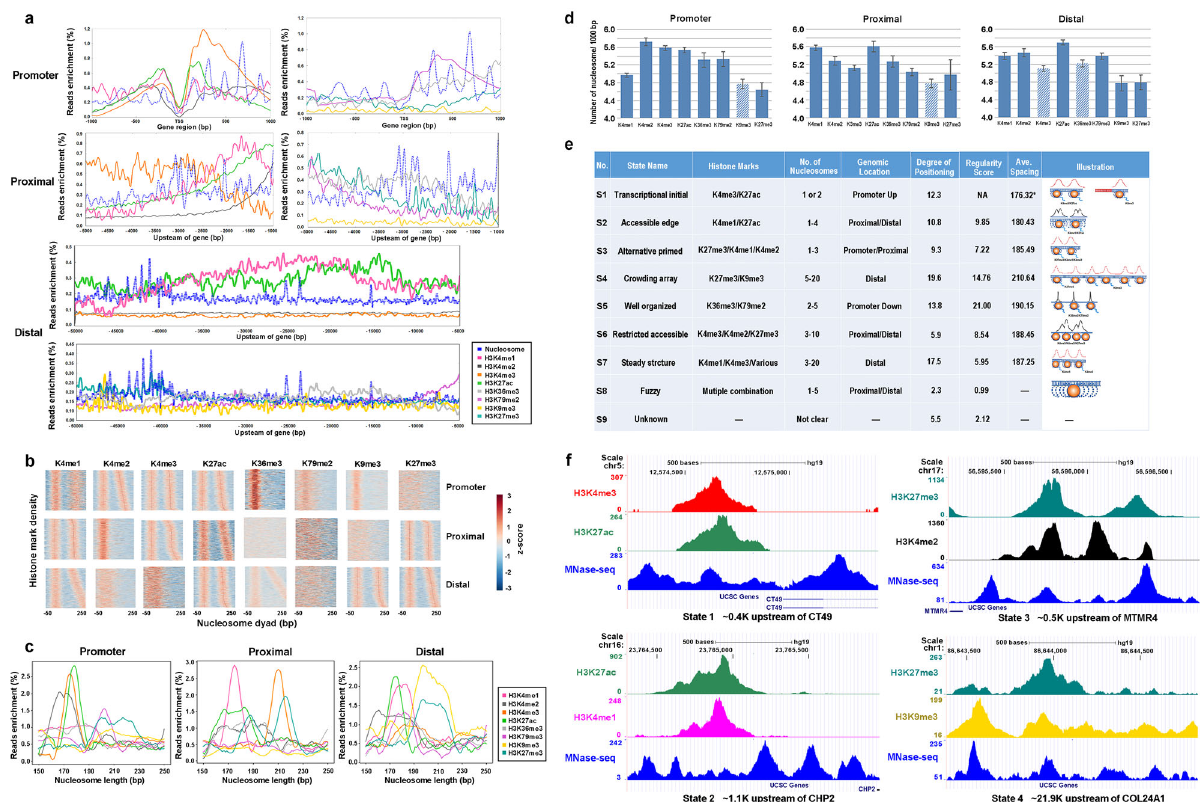
Fig. 2 Quantitatively de fi ning functional nucleosome states. a A distribution of Nucleosome (blue), H3K4me1 (pink), H3K4me2 (gray), H3K4me3 (orange), H3K27ac (green), H3K36me3 (light gray), H3K79me2 (purple), H3K9me3 (yellow), H3K27me3 (cyan) in three genomic regions, Promoter ( − 1 Kb ~1 Kb of transcriptional start site), Proximal ( − 5 Kb ~1 Kb), Distal ( − 50 Kb ~ − 5 Kb) and each line showed an average for biological replicates. b MNase-seq read signal distribution heatmap of histone marks in different genomic regions showing the characteristic spacing and regularity between nucleosomes. c A plot of enrichment curve showing histone mark and genomic region speci fi cally nucleosome spacing pattern. d The density of histone mark-enriched nucleosomes, i.e., No. of nucleosomes per 1000 bp, in three regions and the shadowed bars mean a lower detection of a speci fi c mark in this region. Each bar represents the mean value with the standard deviation as error bars. e Quantitative de fi nition of functional nucleosome states. f The visualization for functional nucleosome states, S1 –